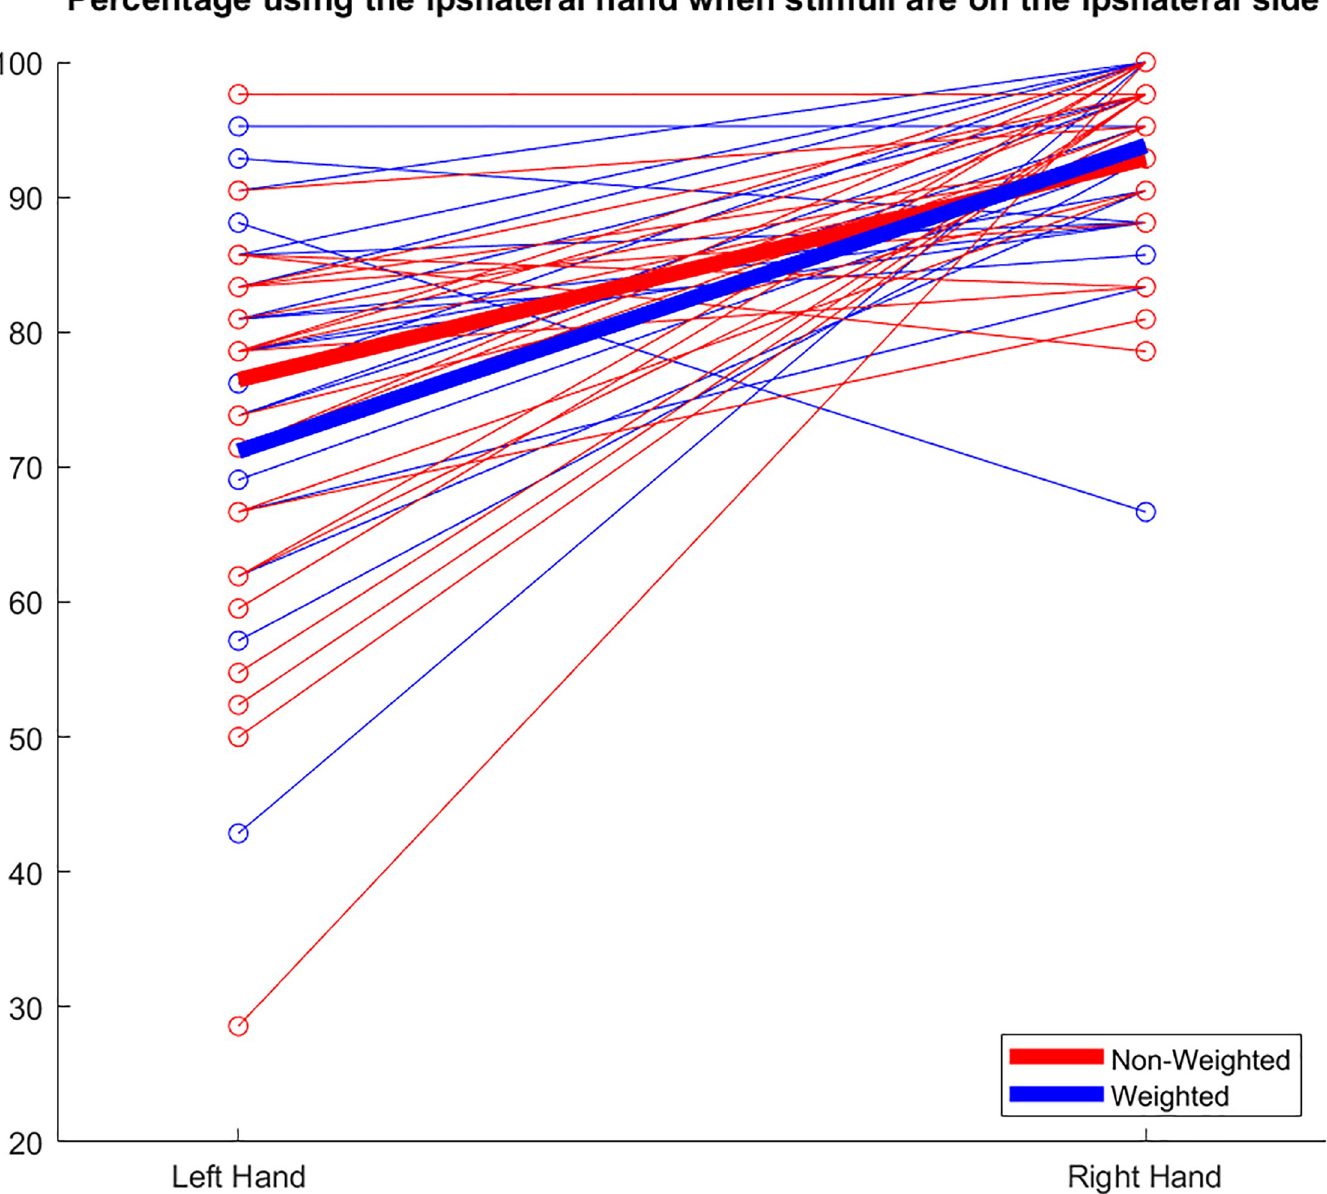
Fig 4. Ipsilateral hand selection. Percentage of selection of left and right hand for their respective ipsilateral targets. The mean values across the group are shown in thick red and blue lines. Individual values from each participant, averaged across trials, are shown as thin, red and blue lines.